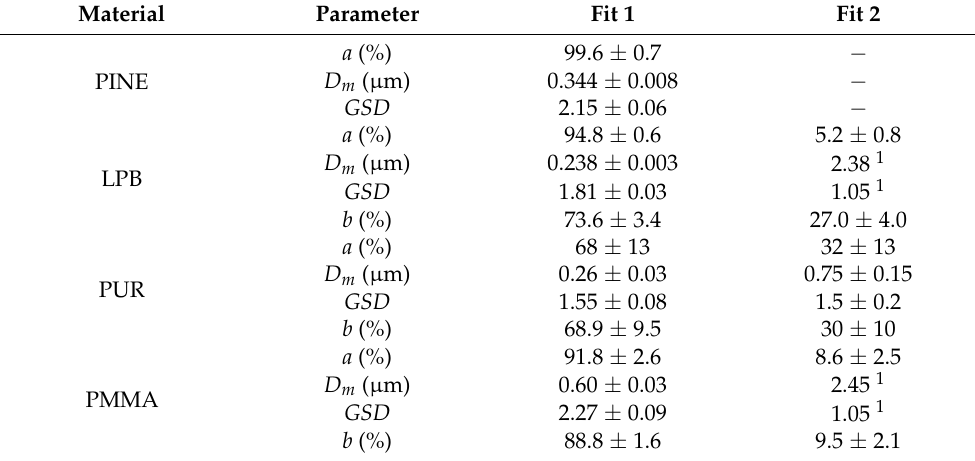
Table 2. Fitted volume abundance a , mean diameter D m , geometric standard deviation GSD , and mass abundance b of the particles emitted during pinewood (PINE), laminated particle board (LPB), polyurethane (PUR), and poly(methyl methacrylate) (PMMA) fires. Material Parameter Fit 1 Fit 2 a (%) 99.6 ± PINE